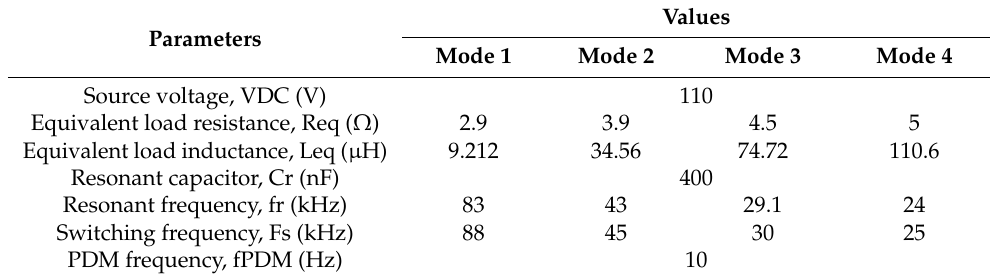
Table 1. Parameters of the proposed